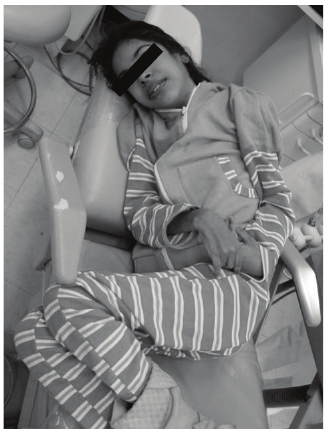
Figure 2: The patient’s clinical appearance at 11 years of age included neuropsychomotordelay,dystonicpostureofthehandsandfeet,and vertical supranuclear gaze palsy